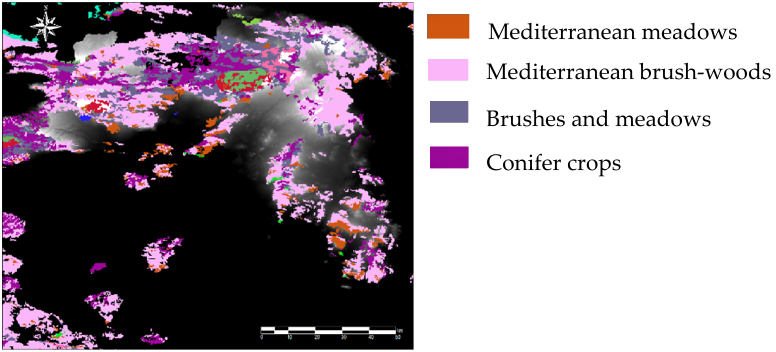
Figure 2. Classification of flammable material in the broader area (background DEM: Hellenic Cadastre).